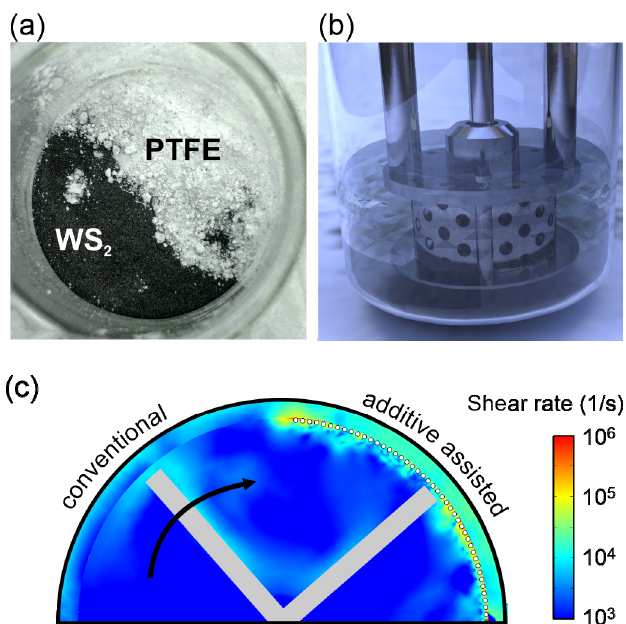
Figure 1. Schematic of additive-assisted exfoliation, ( a ) photograph of WS 2 powder and PTFE additive, ( b ) schematic of the experimental setup, ( c ) Simulation of shear rate enhancement due to mechanical rotor-stator gap decrease.